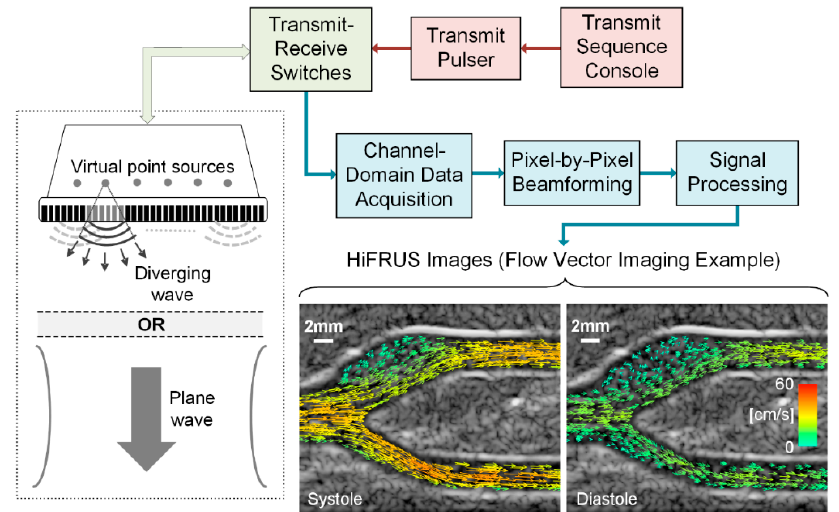
Figure 1. Overview of high frame rate ultrasound (HiFRUS) data acquisition principles and the signal processing chain. Two sample HiFRUS images in the form of flow vector imaging with dynamic visualization [8] are shown in the context of a carotid bifurcation model.